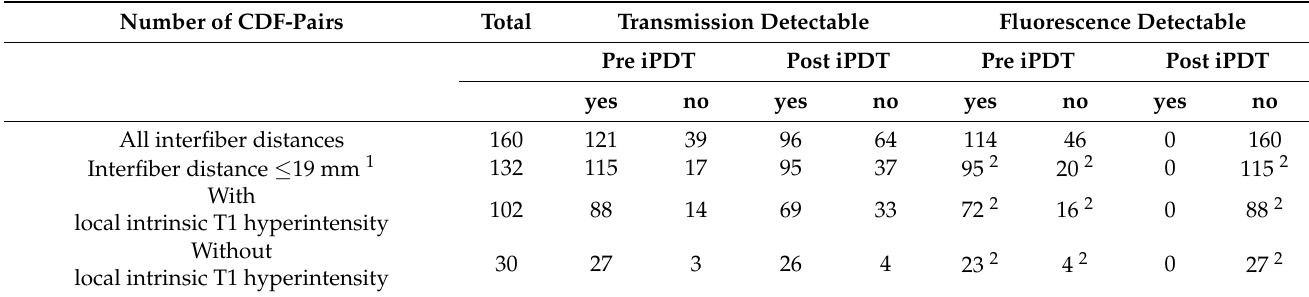
1 Only CDF-pairs with interfiber distance ≤ 19 mm were included in statistical evaluations to avoid bias by spectra with undetectable transmission at “normal” optical tissue properties ( µ a ≤ 0.06 mm − 1 ). 2 Transmission signal detectable pre iPDT (in total 115 CDF-pairs).